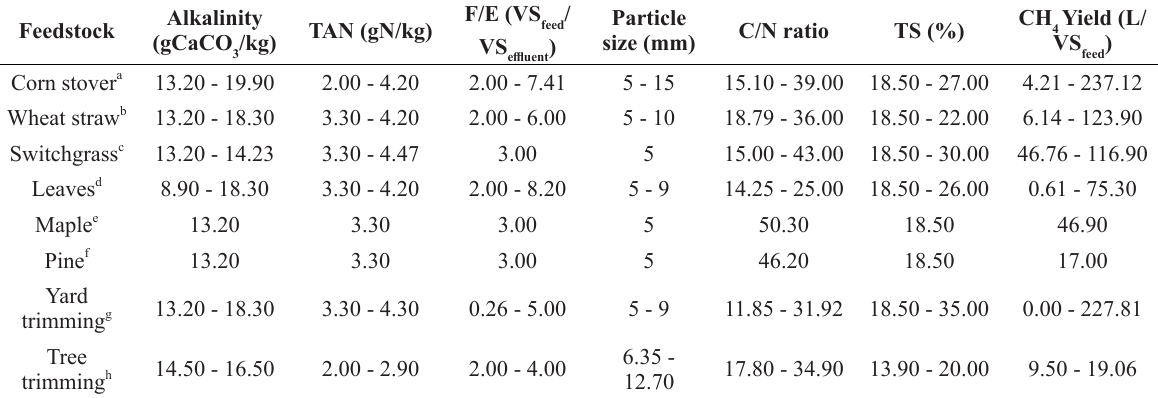
Ranges of inoculum, process characteristics and